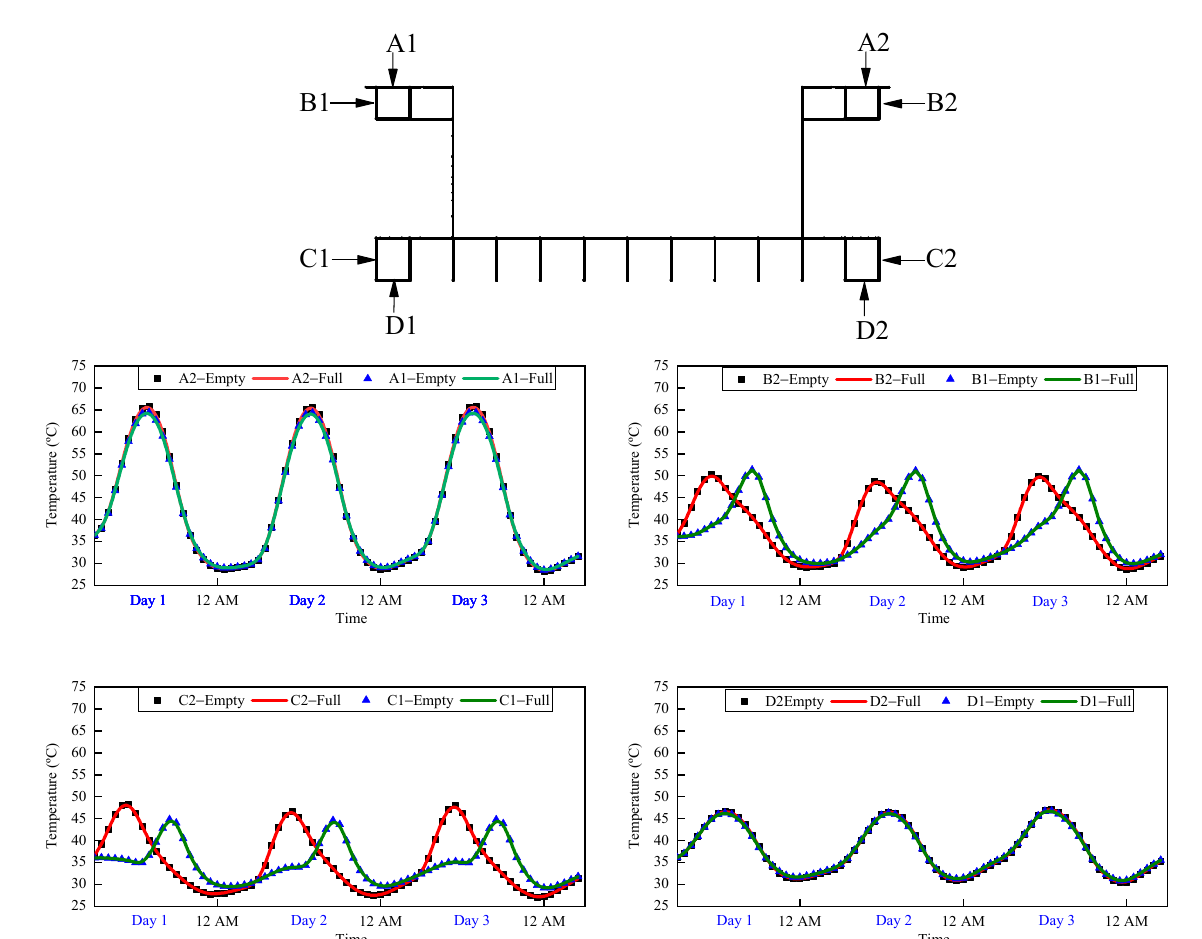
Figure 11. Temperature changes over 72 h on the aqueduct in summer.